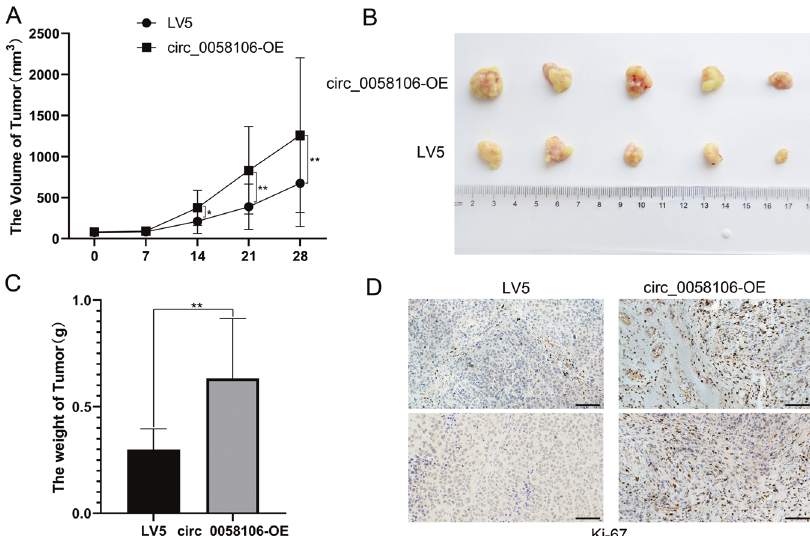
Fig. 4 circ_0058106 overexpression promotes HSCC cells tumorigenesis in vivo. A circ_0058106-OE or LV5 Fadu cells were subcutaneously injected into nude mice (cell numbers = 5 × 10 6 , n = 5 for each group). Tumor size was monitored and calculated by caliper for up to 4 weeks (see Methods). The results were calculated as mean values ± SD. ( n = 5, * P < 0.05; ** P < 0.01) B A photo of fi ve tumors aligned together were presented. C Tumor weight in circ_0058106-OE and LV5 group was measured. ( n = 5, * P < 0.05; ** P < 0.01) D Proliferation of circ_0058106-OE and LV5 group was measured by Ki-67 IHC strain. (Scale bars = 100 μ